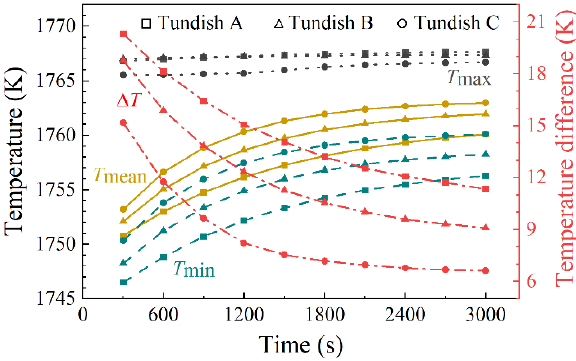
Figure 11. Statistics on temperature of molten steel in distributing chamber. Square represents tundish A, triangle represents tundish B, and circle represents tundish C. Gray dot line represents maximum temperature; yellow solid line represents average temperature; cyan dash line represents the minimum temperature; red dot dash line represents temperature difference between maximum and minimum